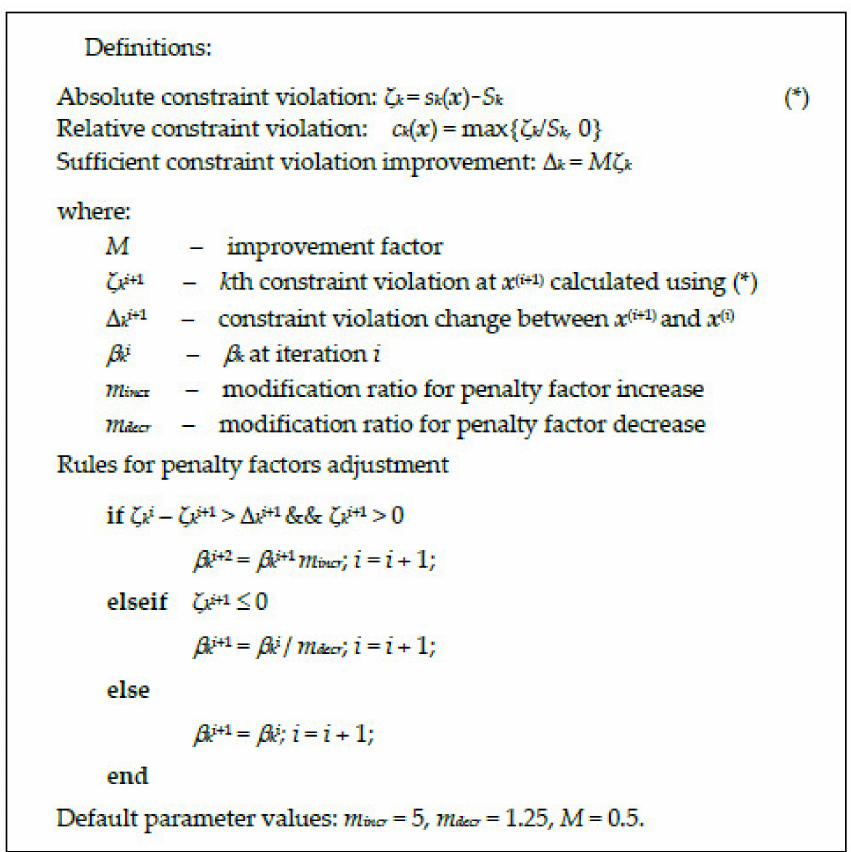
Figure 5. Rules for penalty coefficient adjustment in the methodology of